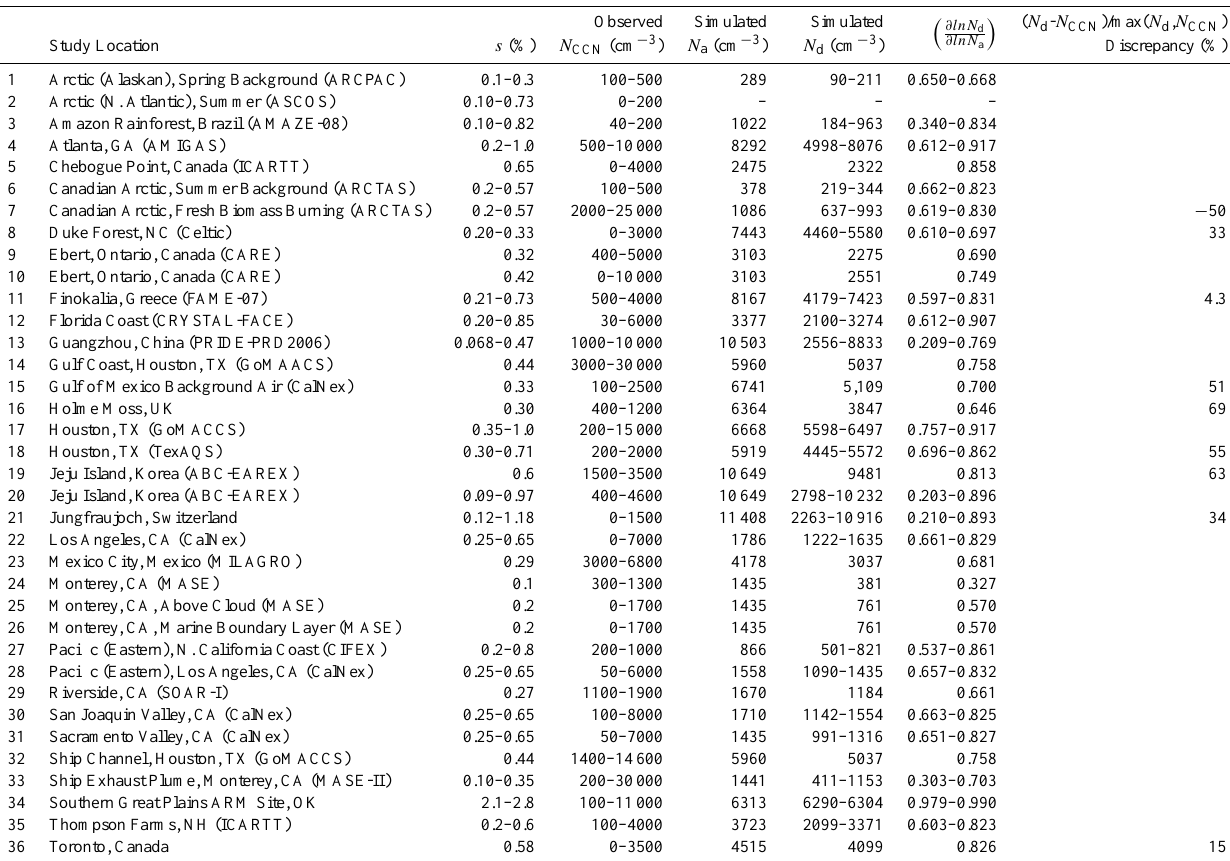
Table 3. Summary of regional observed CCN number concentration, N CCN ; simulated aerosol number concentration, N a ; simulated cloud droplet concentration, N d ; the logarithmic cloud droplet concentration sensitivity, observations. Simulations were carried out using a prescribed s max equal to the instrument supersaturation range in each study.